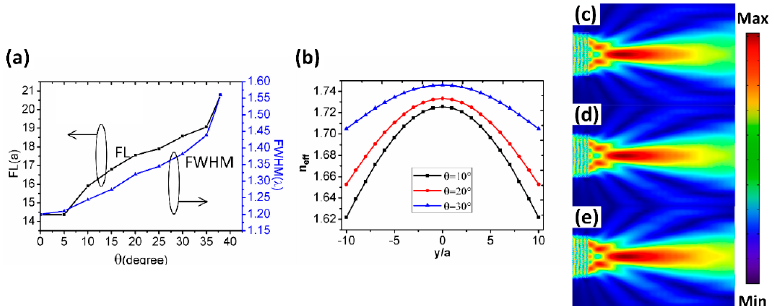
Figure 5. ( a ) The FL and FWHM changes with rotation angles; ( b ) Effective refractive index profile of GPC lens for LC with different rotation angles. The electric field intensities distributions of micro-lens with rotation angle at ( c ) θ = 10° ( d ) θ = 20° ( e ) θ = 30°.